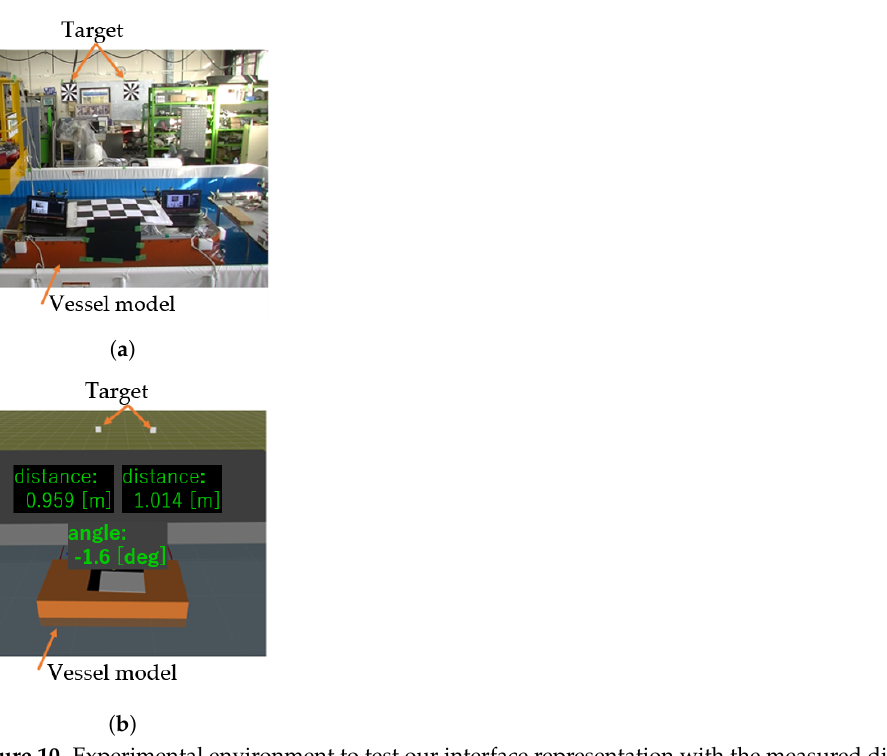
Figure 10. Experimental environment to test our interface representation with the measured distance data: ( a ) real experimental environment; ( b ) visualization